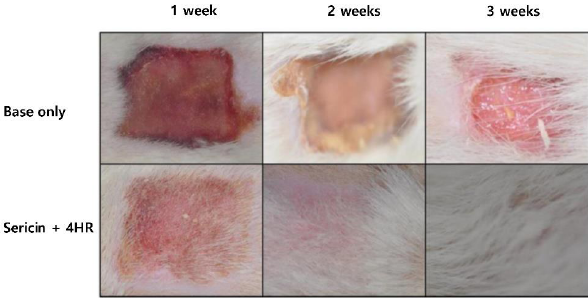
Figure 5. Wound size in each group. Sericin and 4-HR combination ointment shows faster wound healing compared with ointment only group. Reproduced with permission from Kim, S. G.